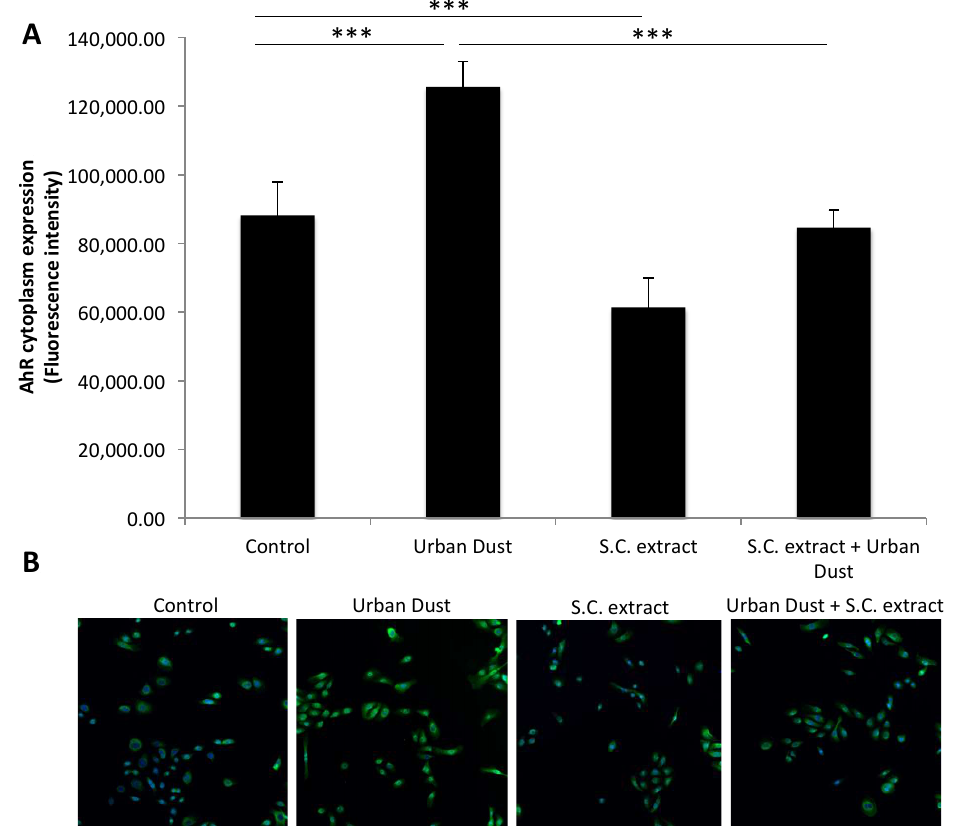
Figure 5. ( A ) AhR cytoplasm expression after Urban Dust exposure, or co-treatment with Urban Dust and S.C. extract. *** p < 0.001. ( B ) Representative pictures of AhR expression: AhR in green, Nucleus in blue.